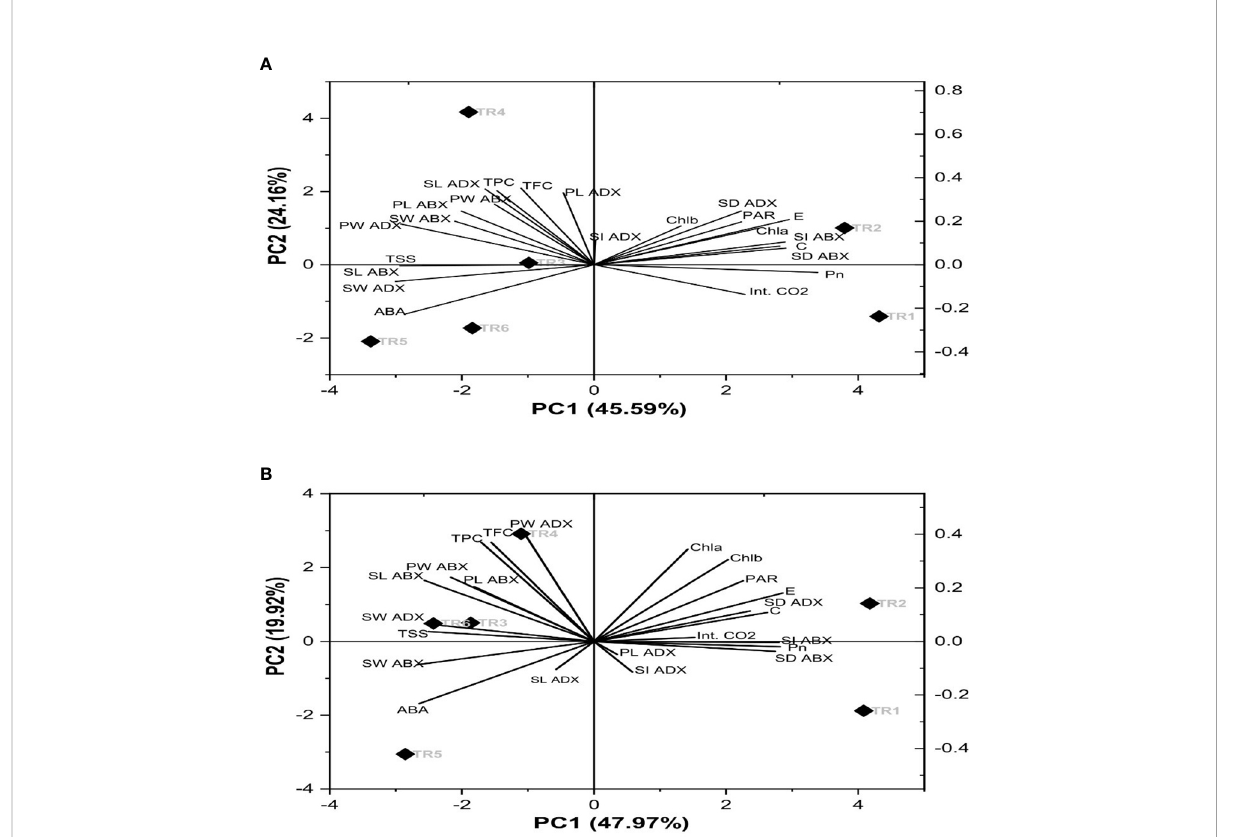
FIGURE 6 Principal component analysis of the chemical components of Essential oil under drought stress in two consecutive seasons. PC: principal component: (A) fi rst season and (B) second season. TR, treatment; ABA, abscisic acid; Chla, chlorophyll a; Chlb, chlorophyll b; Pn, net photosynthesis; C, stomatal conductance; E , transpiration rate; Int. CO 2 , internal carbon dioxide; TSS, total soluble sugars; TFC, total fl avonoid content; TPC, total phenolic content; SL, stomatal length; SW, stomatal width; PL, pore length; PW, pore width; ABX, abaxial; and ADX,